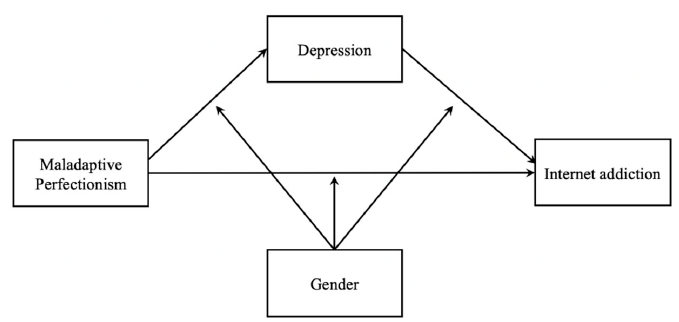
Figure 1. Conceptual framework.